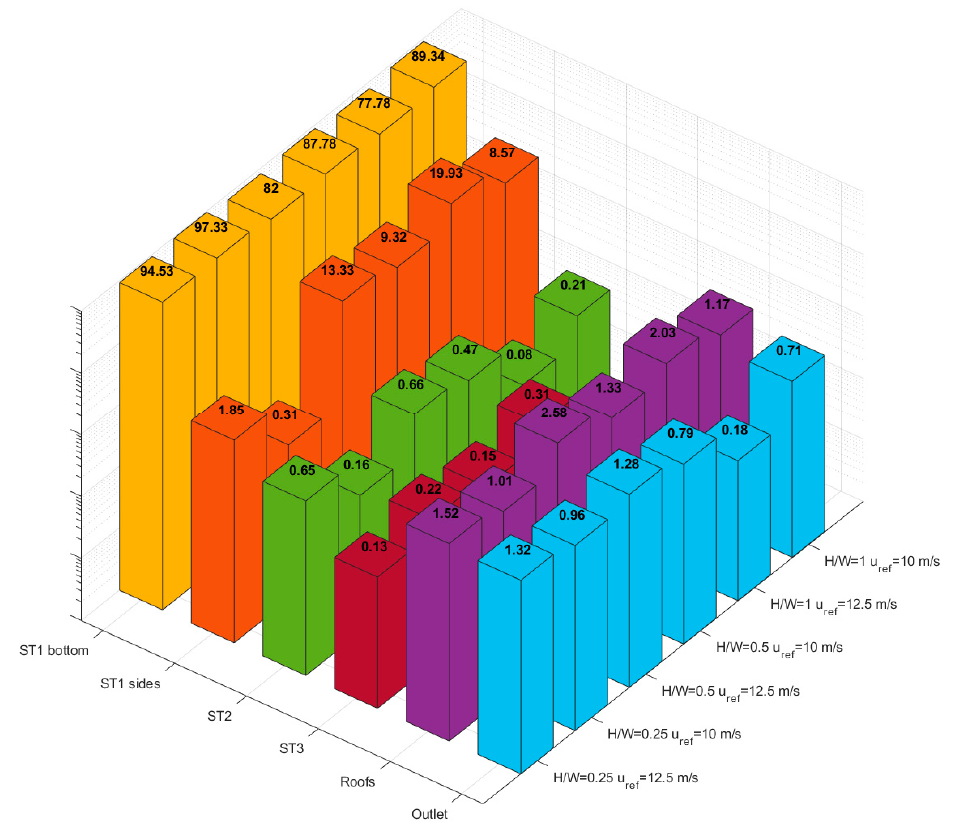
Figure 6. Percentage of the particles (expressed as mass) deposited in different locations in the domain for all the geometrical and flow configurations. The abbreviation ST stands for street canyon. Note the logarithmic Z scale. This is due to large differences in the percentage of particle dispersion in the domain. For H/W = 1, no particles were deposited in ST3.